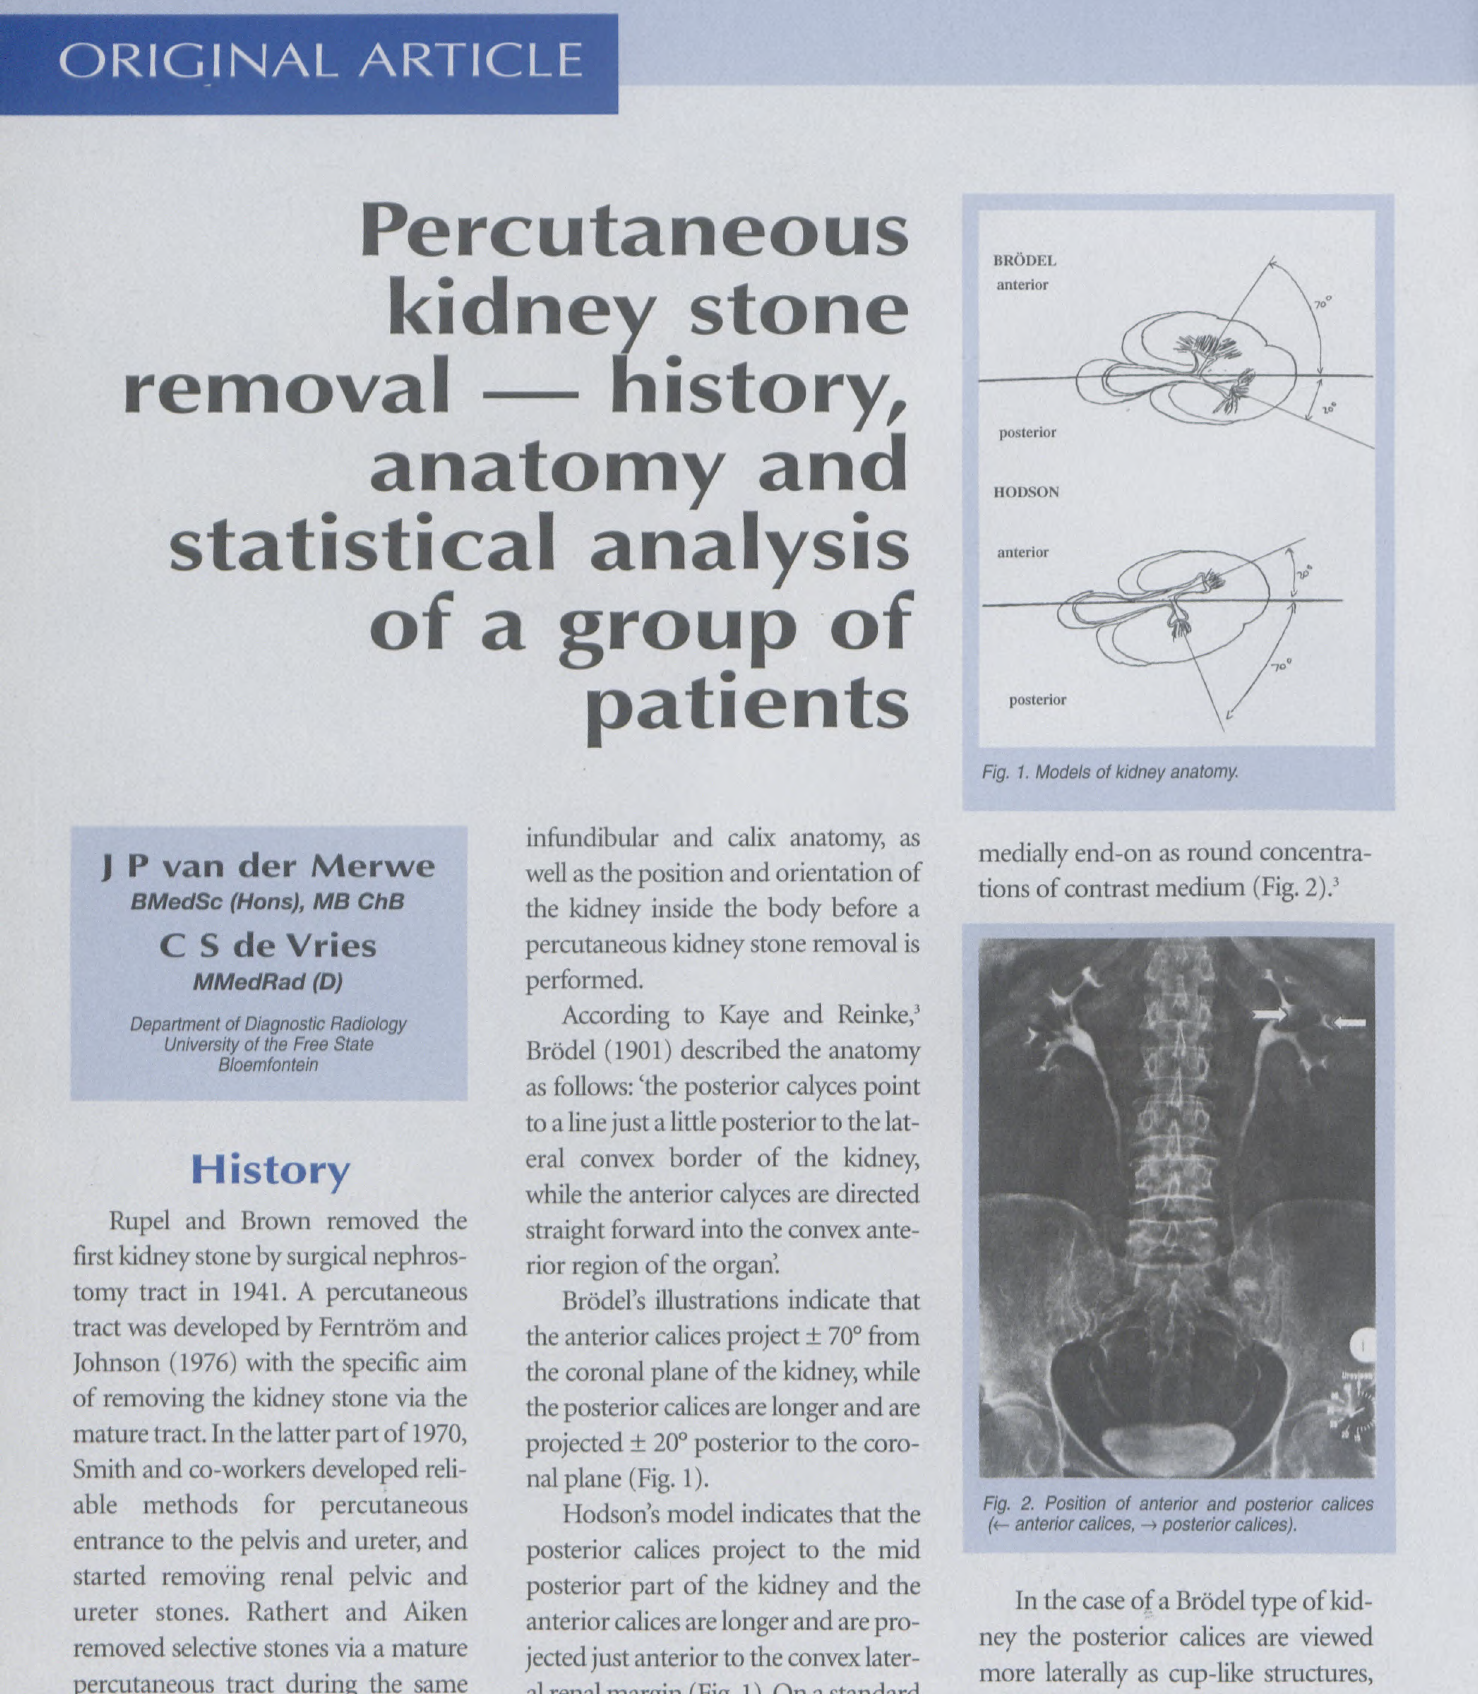
In the case of a Brëdel type of kid- ney the posterior calices are viewed